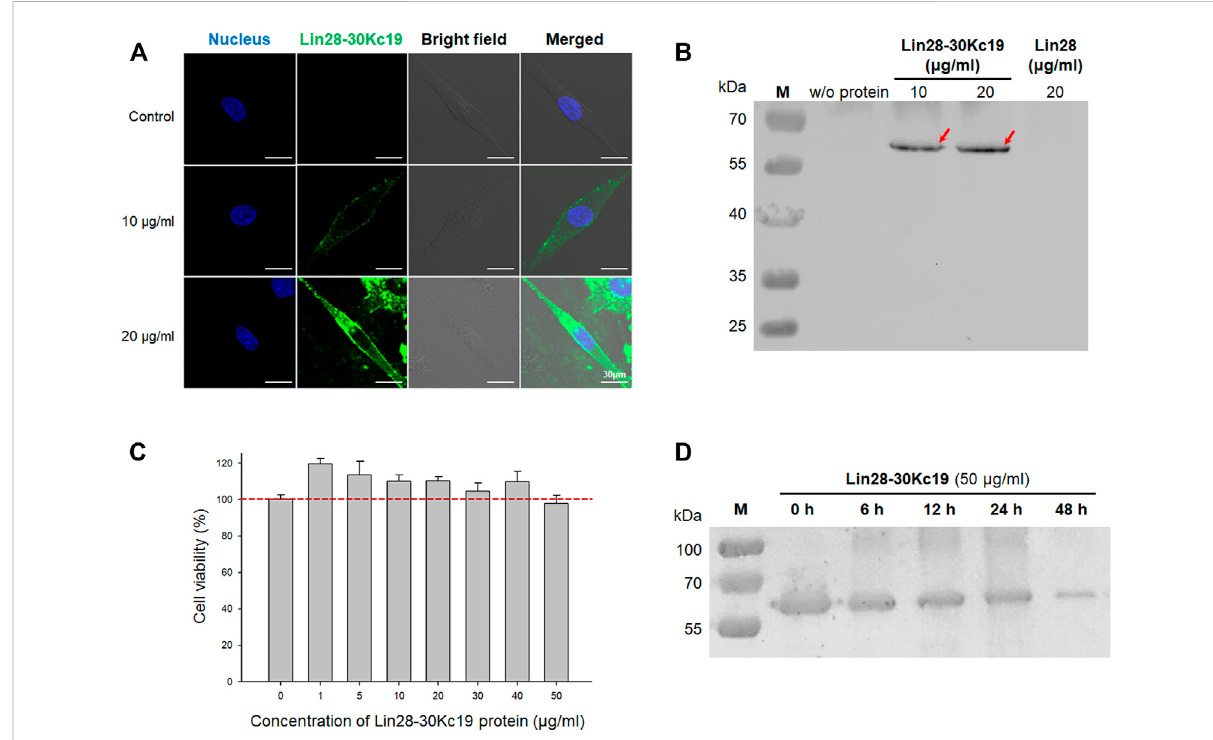
In vitro properties of the Lin28-30Kc19 protein. (A) Confocal images for detecting the intracellular delivery of the Lin29-30Kc19 protein. HDFs treated with 10 and 20 μ g ml − 1 of the Lin28-30Kc19 protein were observed, respectively. Blue fl uorescence indicates the nuclei and green fl uorescence indicates the Lin28-30Kc19 protein. Scale bars indicate 30 μ m. (B) Western blot analysis of the cytosolic fraction of protein-treated cells to con fi rm the cell penetration property. After cultivation of cells with proteins for 24 h, cells were disrupted and then cell lysates were analyzed. Red arrows indicate the intracellularly delivered Lin28-30Kc19 protein. (C) Cytotoxicity of the Lin28-30Kc19 protein, depending on the concentration of theprotein. HDFs were treated with each concentration of theLin28-30Kc19 proteinfor 24 h and then cell viability was